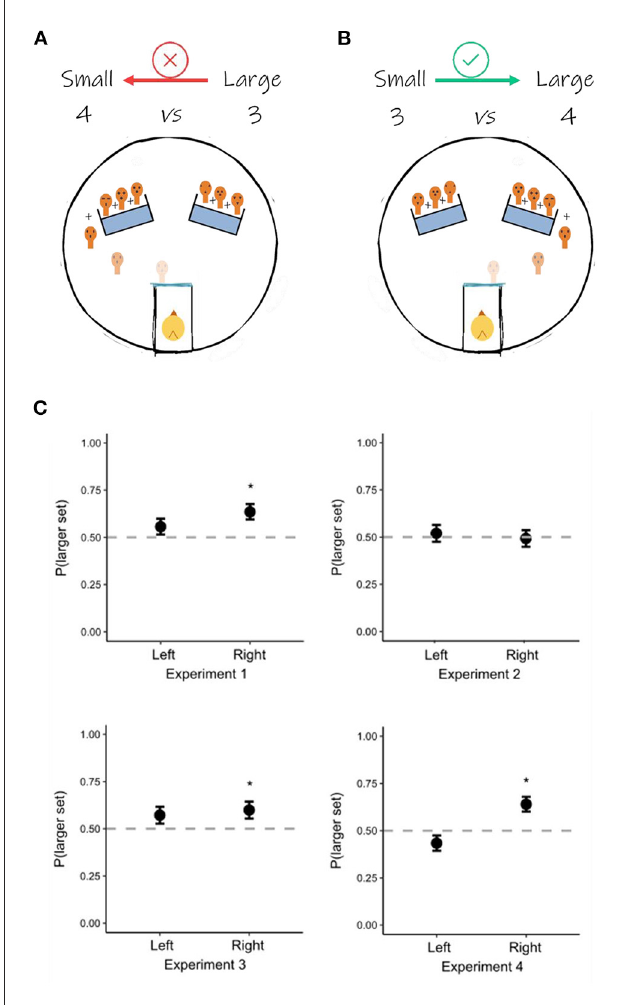
FIGURE1 The experimental paradigm and the spatial-magnitude congruency. (A) In half of the trials (i.e., 10 trials), the larger set disappeared behind the left panel. This could create an incongruent situation (larger on the left and smaller on the right), against the SNA (i.e., smaller values on the left, and larger values on the right). (B) In the other half of the trials, the larger set disappeared behind the right panel. This would be congruent with the SNA representation and therefore constitute facilitation in locating the larger set. (C) The results of the re-analysis. In Exp. 1, Exp. 3, and Exp. 4, chicks succeeded in locating the larger set when it was placed on their right, but not when it was placed on their left. In Exp. 2, chicks failed in locating the larger set and performed at chance, irrespective of its spatial location. * p < 0.05.